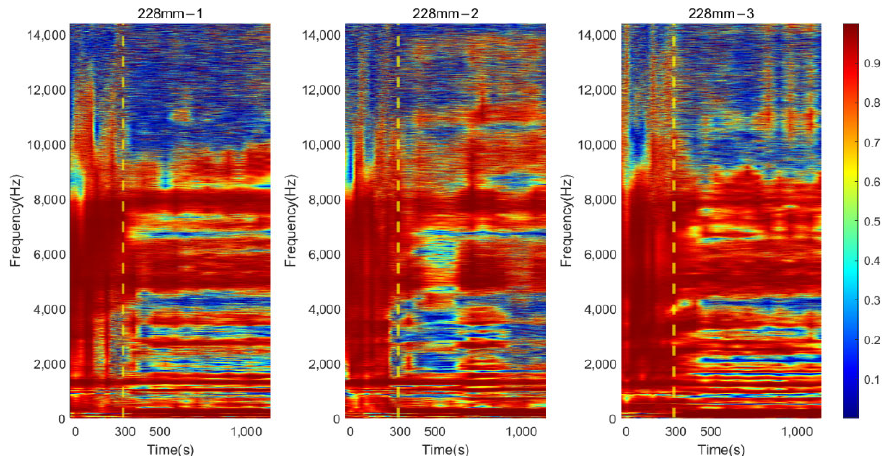
Figure 6. Coherence function for residual length of 228 mm.